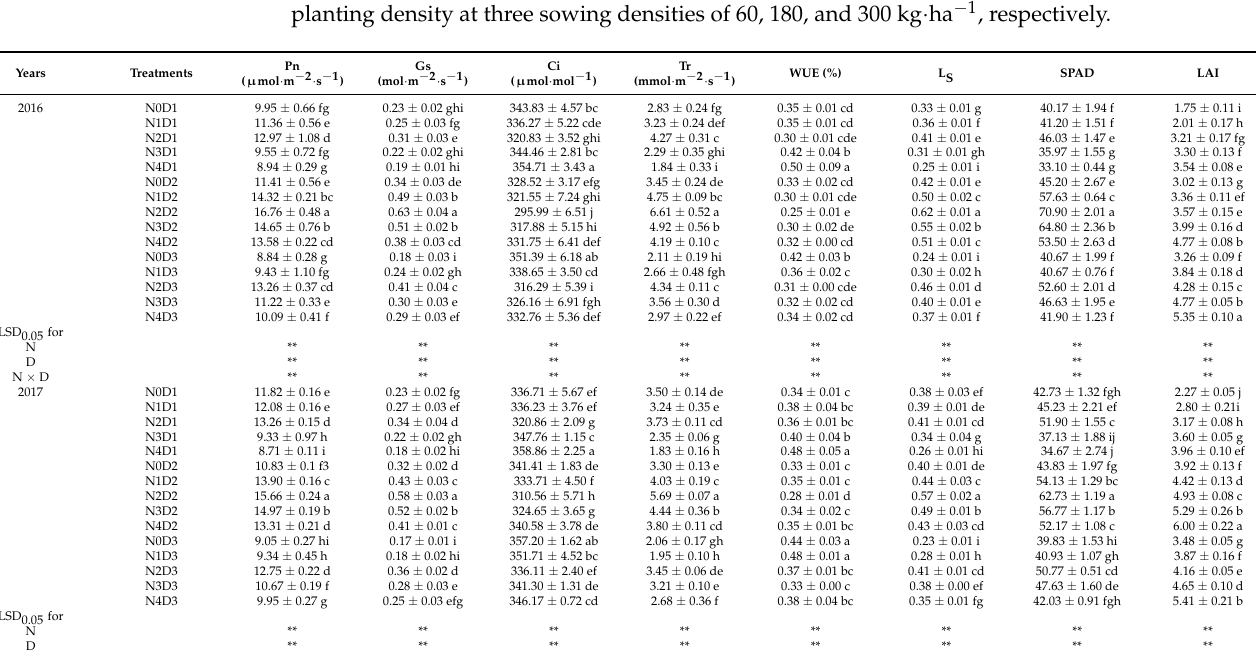
Table 2. Net photosynthetic rate (Pn), stomatal conductance (Gs), intercellular CO 2 concentration (Ci), transpiration rate (Tr), water-use efficiency (WUE), stomatal limitation value (Ls), and leaf area index (LAI) of oat in different nitrogen fertilizer and planting density treatments in two cropping seasons. Data are expressed as the mean of three replications ( n = 3). Data within a column in the same year, sharing the same letter, are not significantly different at p < 0.05; ns, not significant; ** significant at p < 0.01. N, D, and N × D represent nitrogen fertilizer, planting density, and the interaction between nitrogen fertilizer and planting density, respectively. N0, N1, N2, N3, and N4 represent nitrogen fertilizer rates at five levels of 0, 45, 90, 135, and 180 kg · ha − 1 , respectively. D1, D2, and D3 represent planting density at three sowing densities of 60, 180, and 300 kg · ha − 1 ,